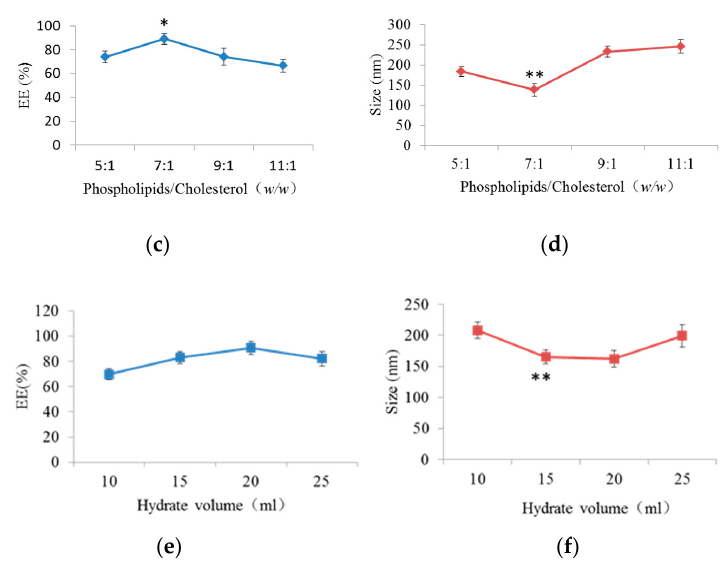
Figure 2. The influence of different single factors on the EE ( a – c , %) and size ( d – f , nm) of GGB-LP. * p < 0.05, ** p < 0.01, vs. lipid/drug ratio at 6:1, or phospholipid/cholesterol weight ratio at 5:1, or hydrate volume at 10 mL.